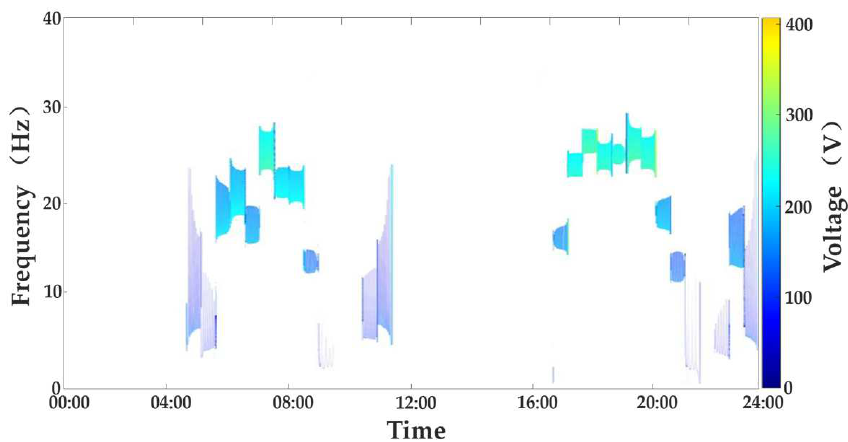
Figure 5. Hilbert spectrum of the daily generation waveform of tidal power.